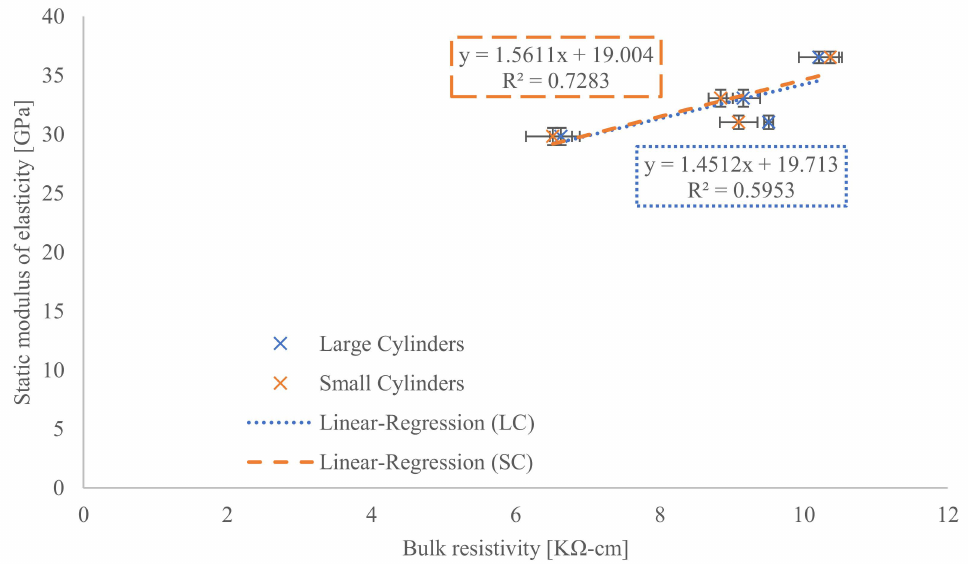
Figure 11. Linear regression analysis of the relationship between bulk electrical resistivity and dynamic modulus of elasticity (LC = Large Cylinders, SC = Small